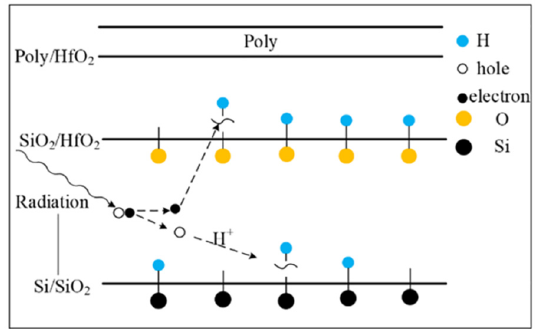
Figure 8. Radiation produces defects in the oxide layer.